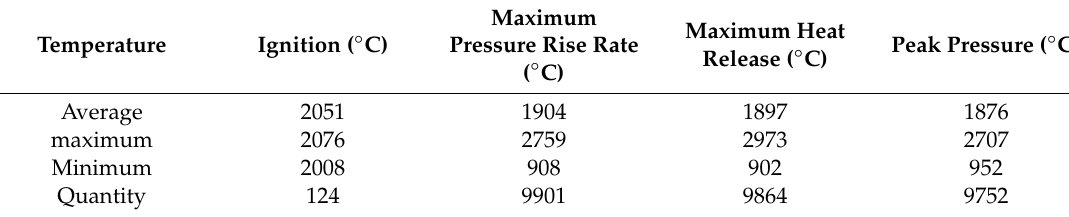
Figure 7. Calculated temperature field image of series 2 with CMS. ( a ) Ignition moment; ( b ) maximum pressure rise rate; ( c ) maximum heat release; ( d ) the highest pressure. Tables 3 and 4 are the typical temperatures of the two series calculated by CMS2002. Table 3. Typical temperature of series 1 with CMS.